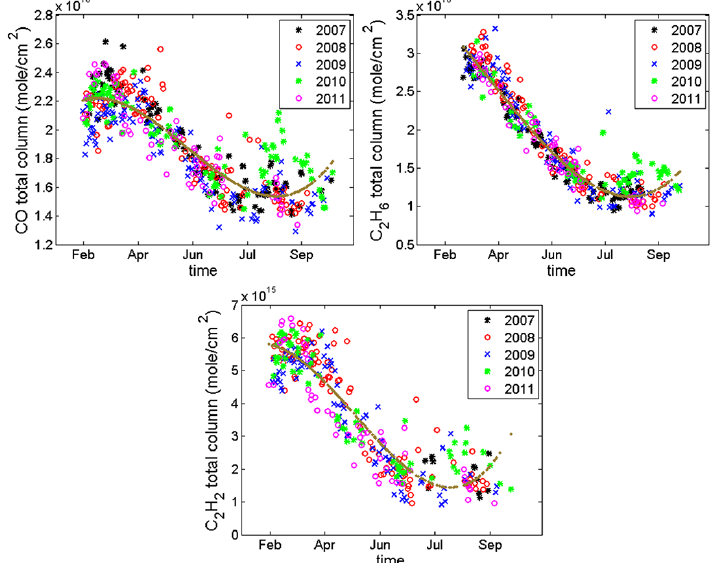
Figure 10. Daily mean total columns (in moleculescm − 2 ) of CO, HCN and C 2 H 6 , plotted in different colours for the different years of measurements. The brown lines show the polynomial fits to the data.